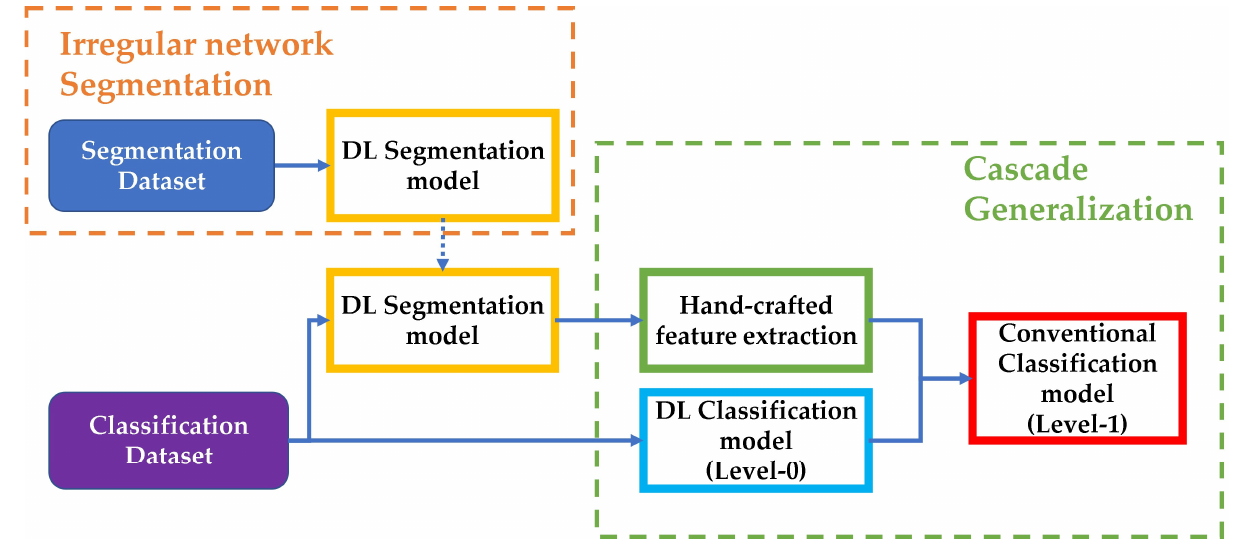
Figure 2. Overview of the steps involved in our implementation. The segmentation dataset is used to train and test the DL segmentation model. The segmentation model is used over the classification dataset to generate masks and extract hand-crafted features for level-1 of the Cascade generalization pipeline. The classification dataset is also used to train a DL classification model (level-0), which is used with the hand-crafted features to train conventional classifiers for the final diagnosis classification.